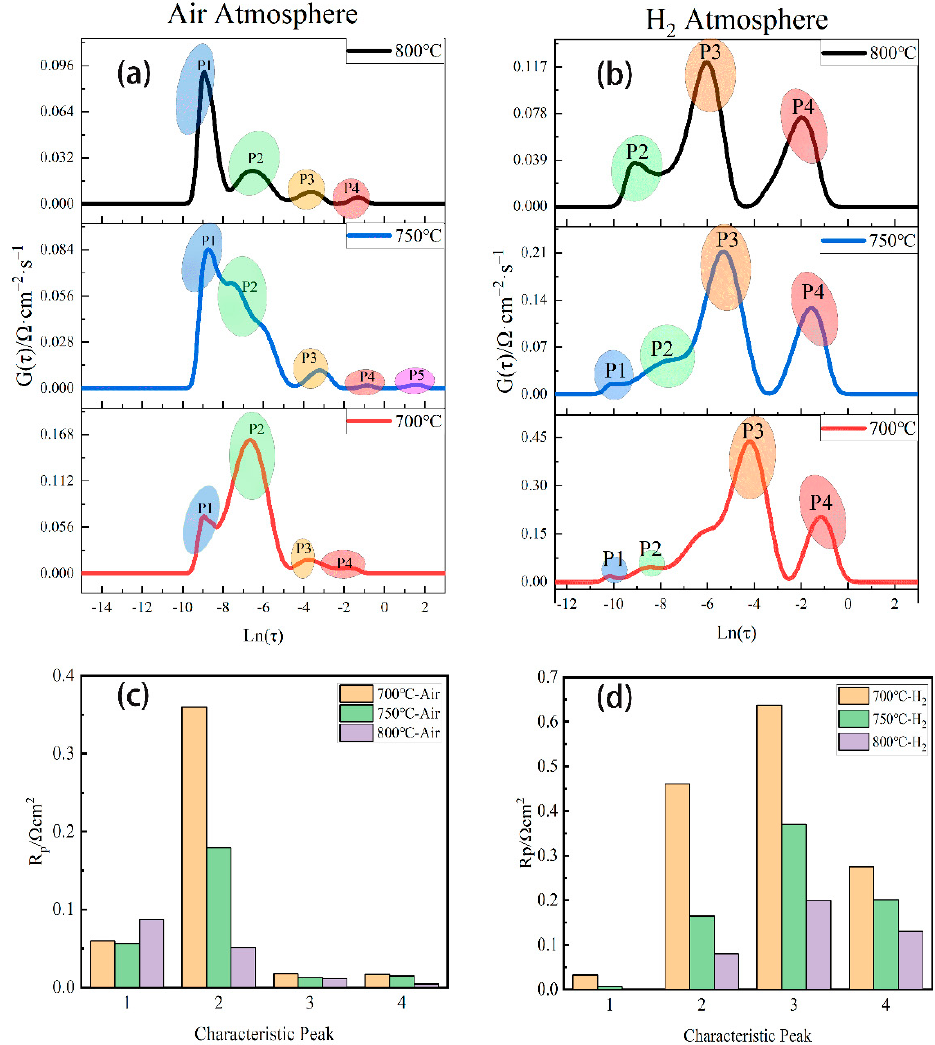
Figure 6. DRT analysis results of impedance spectra and simulated resistances corresponding to characteristic peaks from 700 °C to 800 °C, under oxidizing conditions ( a , c ) and reducing conditions ( b , d ).